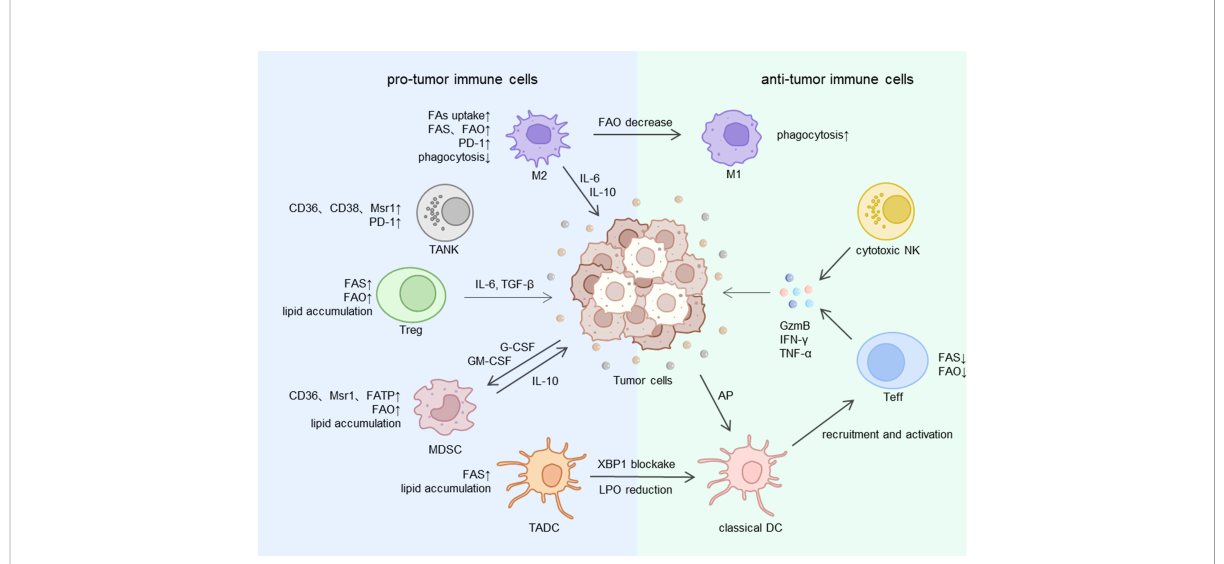
FIGURE 2 The lipid metabolism of immune cells in TME. FA, fatty acid; FAS, fatty acid synthesis; FAO, fatty acid oxidation; Msr1, macrophage scavenger receptor 1; FATP, fatty acid transport protein; XBP1, X-box binding protein 1; LPO, lipid peroxidation; AP, antigen presentation; IL, interleukin; TGF, tumor growth factor; G-CSF, granulocyte colony stimulating factor; GM-CSF, granulocyte macrophage colony stimulating factor; GzmB, granzyme B; IFN, interferon; TNF, tumor necrosis factor; M1, M1 macrophage; M2, M2 macrophage; NK, natural killer cell; TANK, tumor- associated natural killer cells; Teff, effective T cell; Treg, regulatory T cell; MDSC, myeloid-derived suppressor cell; DC,dendritic cell; TADC, tumor-associated dendritic